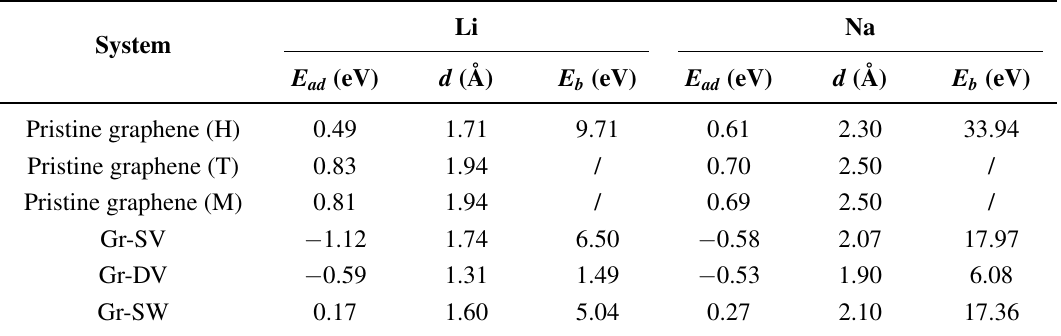
Table 2. Adsorption energy ( E ) of ions, distance of ions from the graphene sheet ( d ) and ad diffusion barrier ( E ) for the pristine and defected systems b